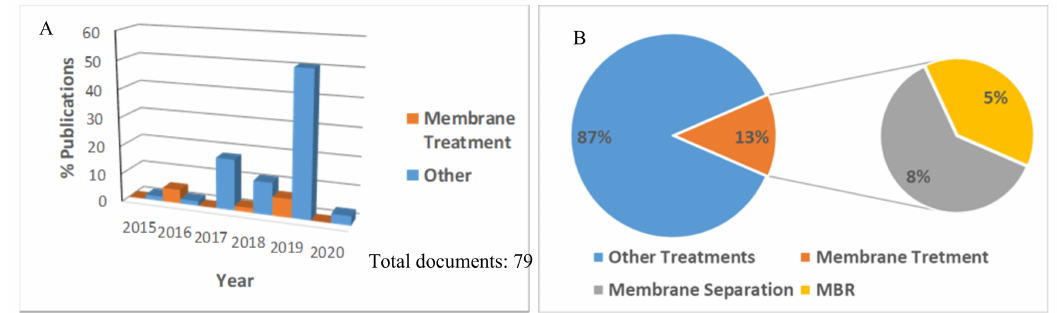
Figure 2. ( A ) The distribution of publications related to microplastic contaminant removal from 2015 to 2020 and ( B ) the incidence of the research on membrane technology applications with respect to other existing treatment